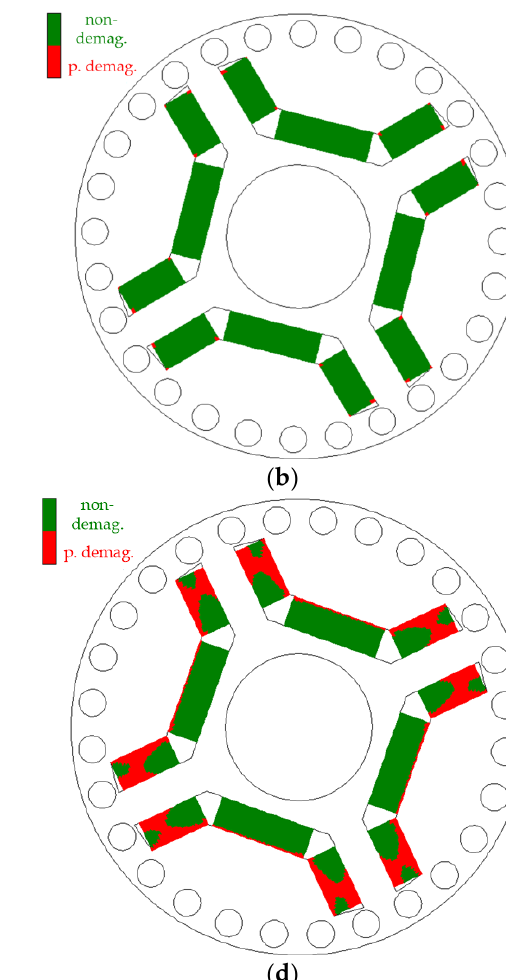
Figure 16. Distribution of magnetic flux density B s for T L = 0 Nm, τ i = 100°C , J before start-up, ( b ) after start-up at t = 0.6 s.